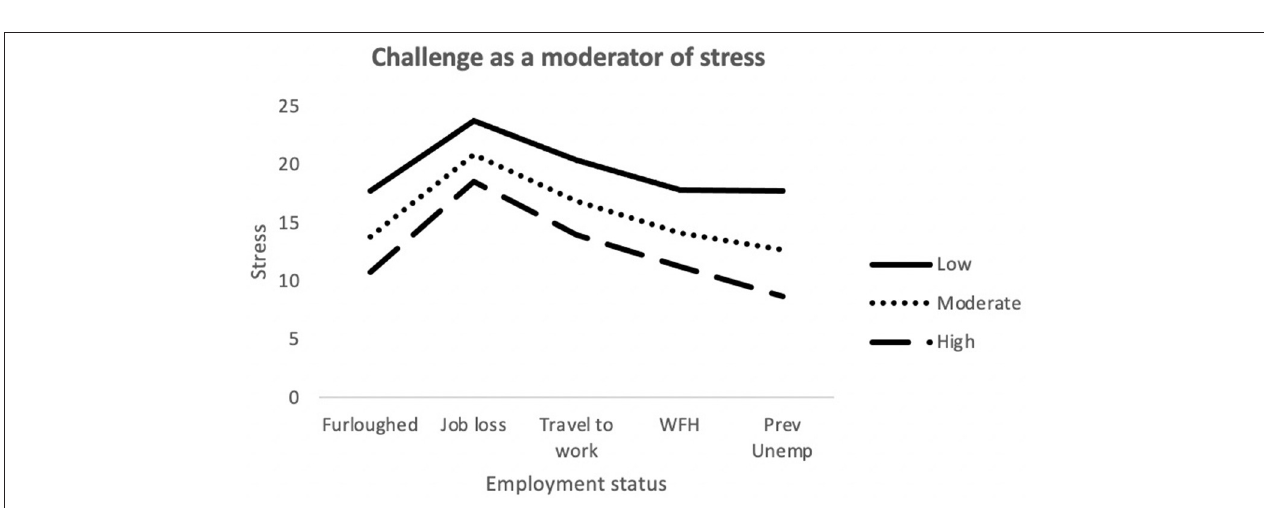
FIGURE 3 | Interaction between job outcome and Confidence for Depression. WFH, Employed (working from home); Prev Unemp, previously unemployed.